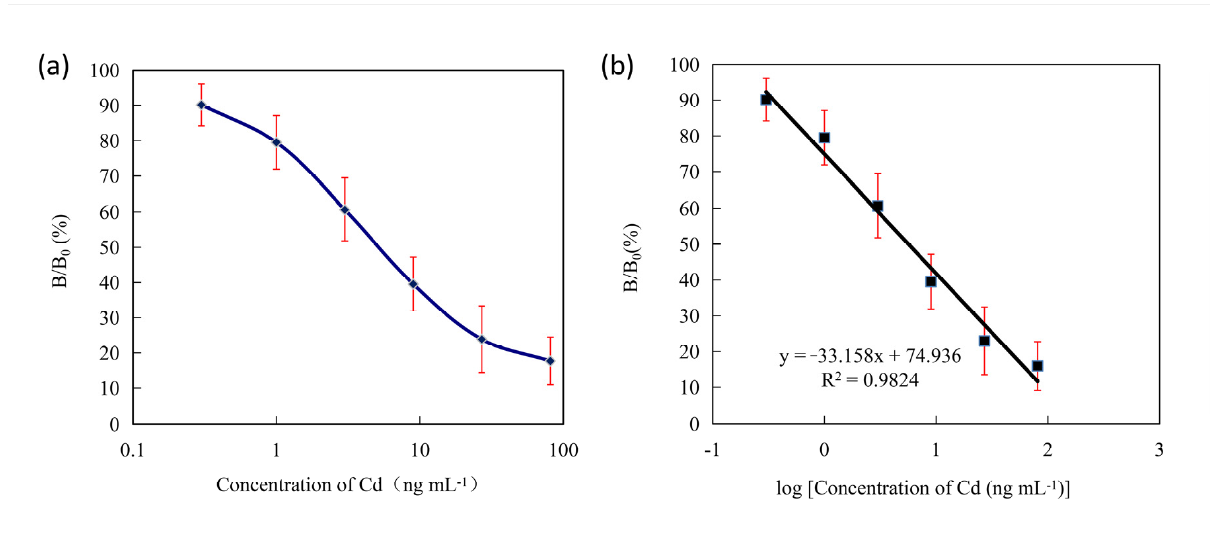
Figure 4. The standard representative curve ( a ) and standard calibration curve ( b ) of Cd (II) indirect competitive enzyme- linked immunosorbent assay (ic-ELISA). Each point represented the average of 12 replicates. The concentrations of Cd (II) standard solution were 0.33, 1.0, 3.0, 9.0, 27.0 and 81.0 ng mL − 1 , respectively. Table 2. Cross-reactivity of anti-cadmium monoclonal antibody with Cd (II) and other metal